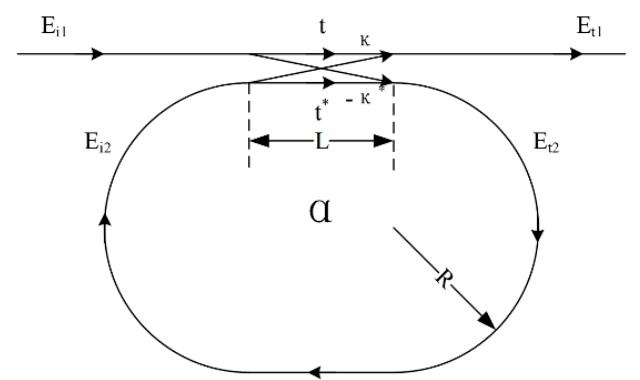
Figure 2. Schematic of the racetrack micro-ring resonator.